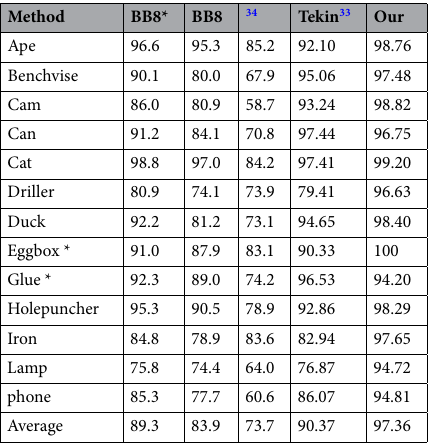
Table 2. Evaluation and comparison on the Linemod dataset in terms of the 2D projection metric. With refinement methods are marked with *.